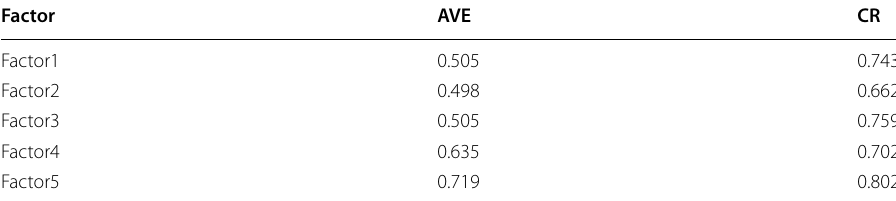
Table 5 AVE and CR